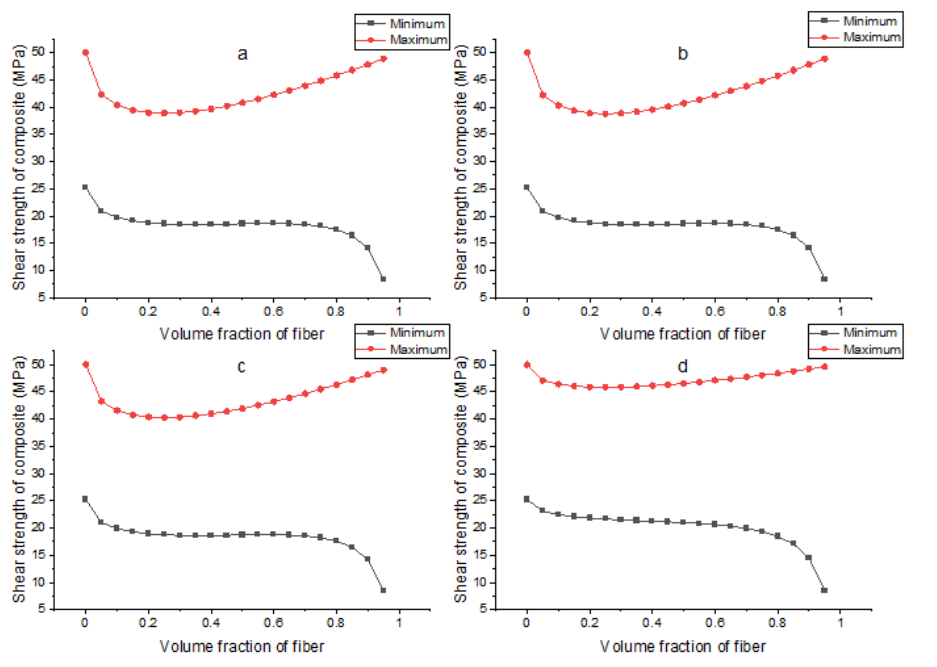
Figure A9. Depicts the variation in shear strength of ( a ) E-glass, ( b ) S-glass, ( c ) T300 carbon fiber and ( d ) AS carbon with volume of fiber. It can be seen that a wide range between minimum and maximum shear strength is obtained with increasing fibre